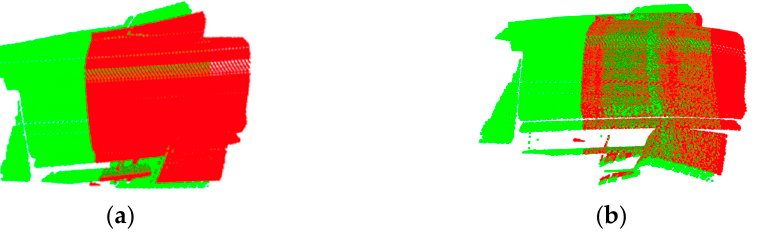
Figure 21. Comparison of the overall stitching effect of the vehicle nose. ( a ) Initial point cloud stitching. ( b ) DeepMerge algorithm correction.